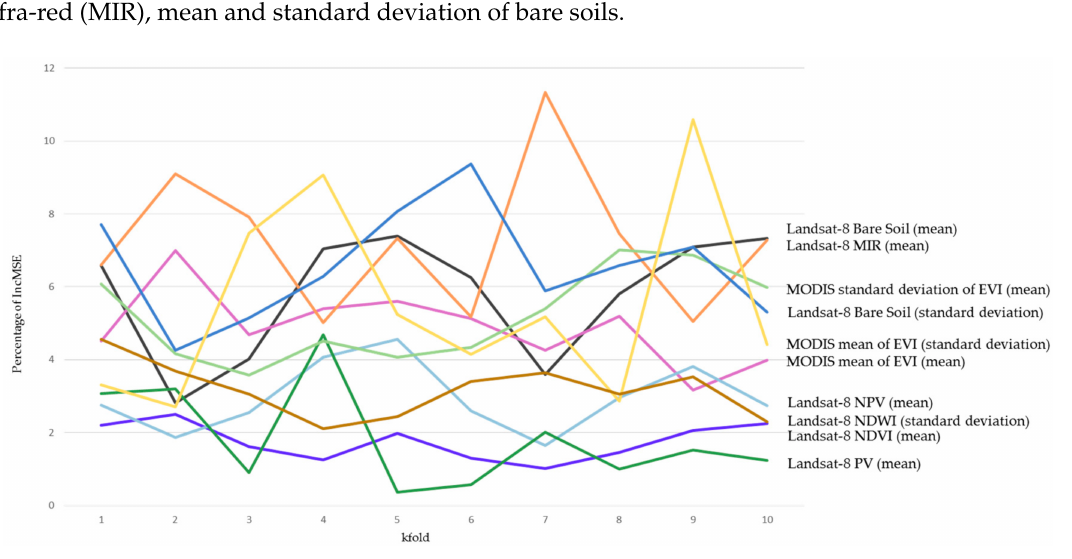
Figure 3. Explained indicator performance (Percentage of IncMSE) of the Random Forest